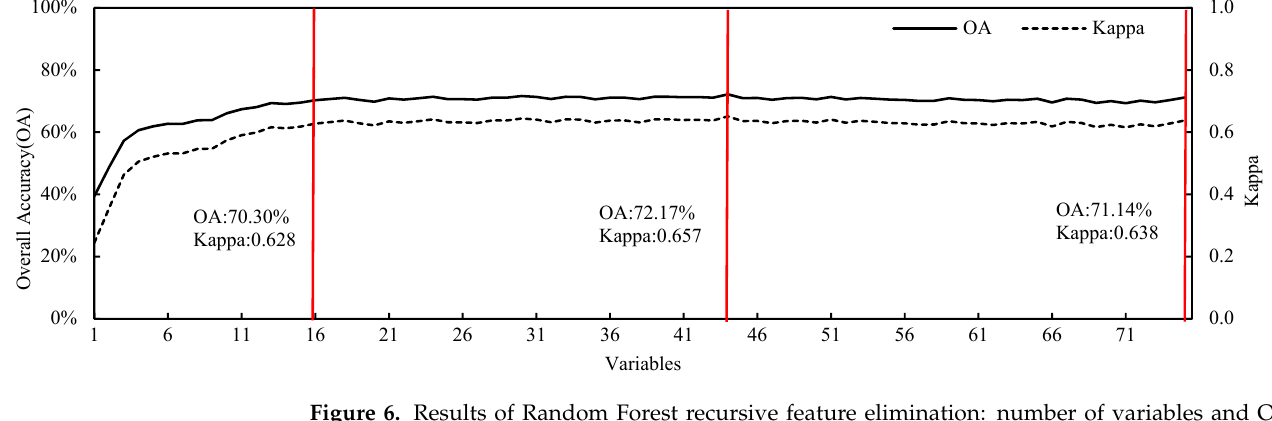
Figure 6. Results of Random Forest recursive feature elimination: number of variables and OA and Kappa of the mode. Three vertical red lines represented 16 variables (the minimum number of features to achieve an accuracy higher than 70%), 44 variables (the number of features to obtain the highest OA and Kappa), and 75 variables (all the features) were considered, respectively.